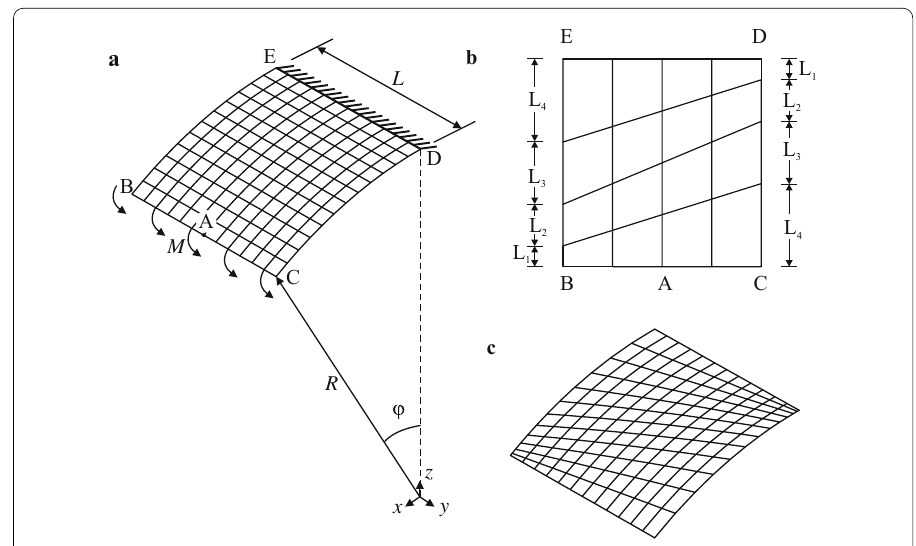
Fig. 12 Cylindrical shell segment: a problem and 12 × 12 regular mesh, b principal mesh distortion for a